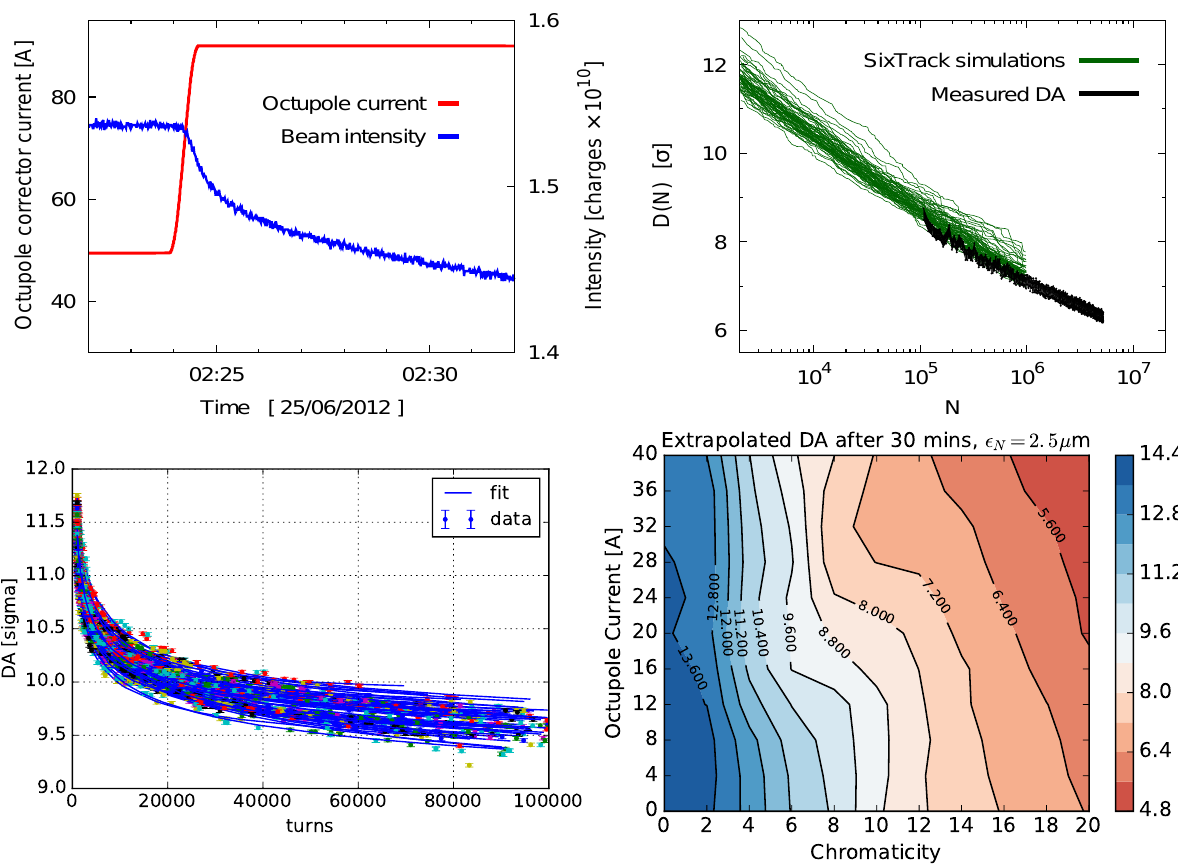
Figure 6: Upper left: measured beam intensity evolution during an experimental session. Upper right: comparison between simulated and measured DA of the LHC at injection. Lower left: DA evolution with the number of turns from SixTrack simulations compared against fits of the data for the individual seeds. Lower right: Extrapolated DA of LHC at 30 minutes after injection as a function of different chromaticities and octupole